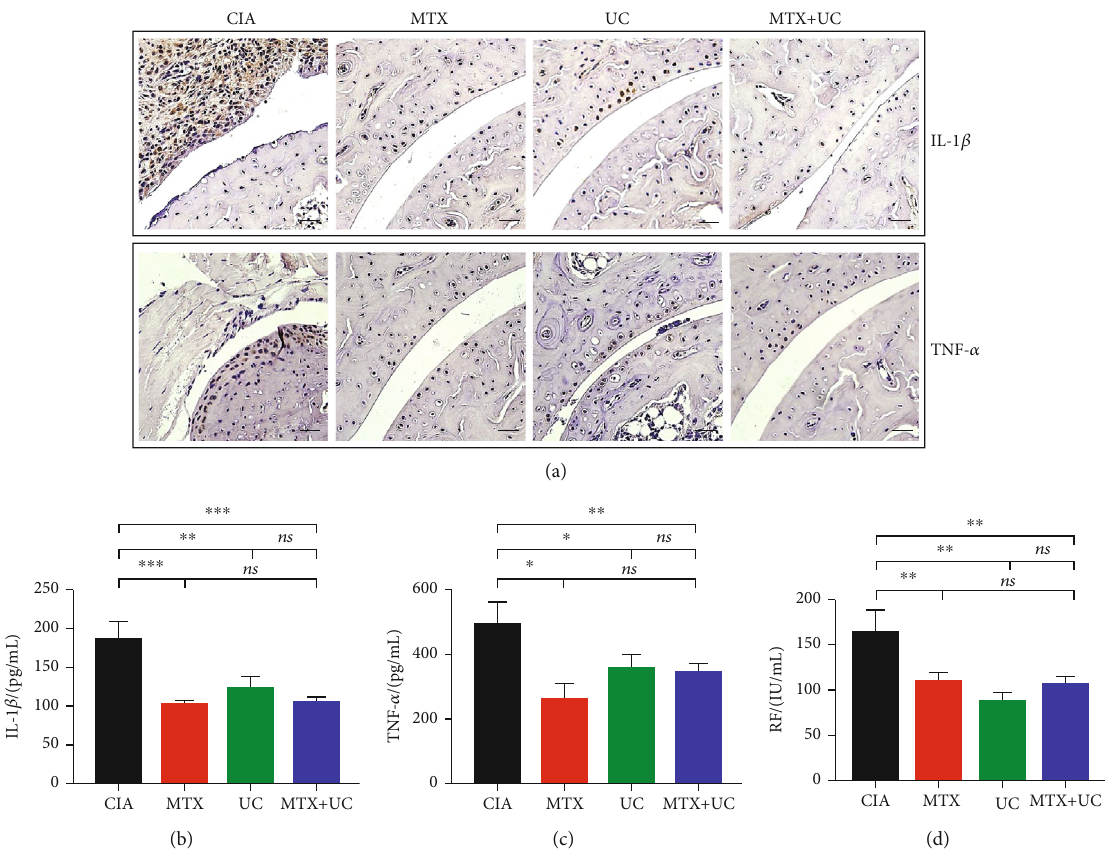
Figure 2: Combined use of UCs and MTX reduced the levels of in fl ammatory cytokines and rheumatoid factors. (a) Representative images of immunohistochemical staining in joints of CIA mice. The MTX+UC group reduced the expression of IL-1 β and TNF- α accumulated in joints compared to the other three groups. Serum levels of TNF- α (b), IL-1 β (c), and rheumatoid factor (d) were measured by ELISA. Scale bar, 100 μ m. n = 3 per group. Data are shown as mean ± SD . ∗ P < 0 : 05 ; ∗∗ P < 0 : 01 ; ∗∗∗ P < 0 : 001 ; ns: not signi fi cant ( P > 0 : 05